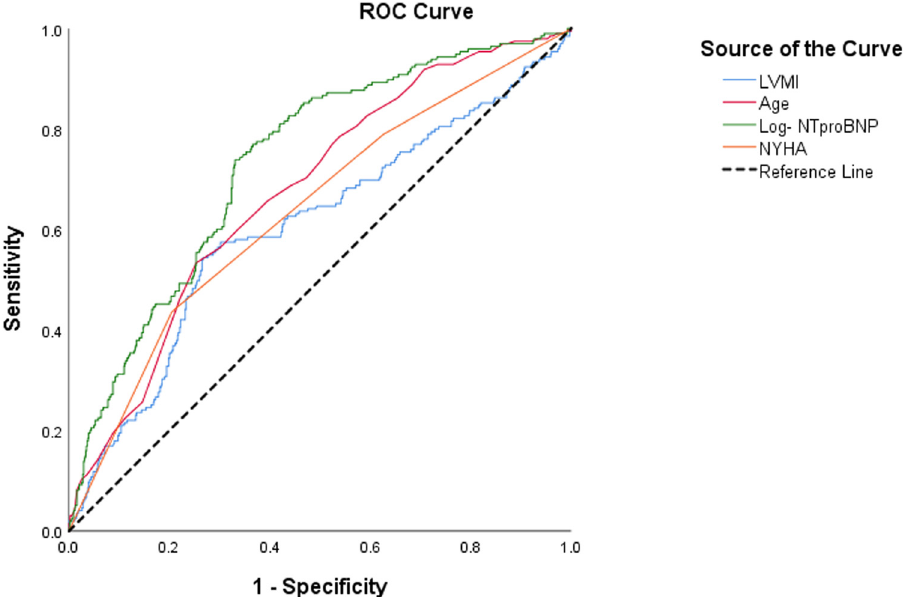
Figure 1: ROC curve. Abbreviations: ROC, receiver operating characteristic; LVMI, left ventricular mass index; NT - proBNP, N - terminal pro - B - type natriuretic peptide; NYHA, New York Heart